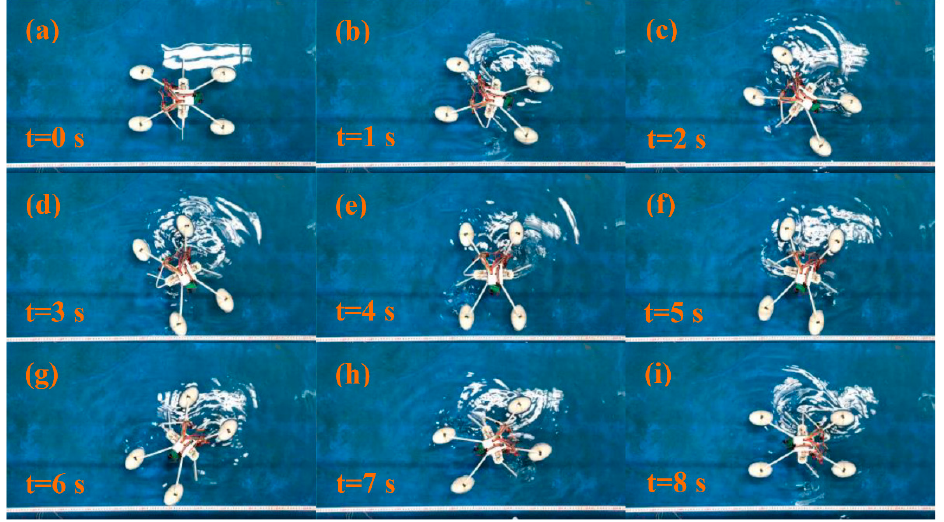
Figure 19. The positions of the robot at different times t: ( a ) 0 s, ( b ) 1 s, ( c ) 2 s, ( d ) 3 s, ( e ) 4 s, ( f ) 5 s, ( g ) 6 s, ( h ) 7 s, and ( i ) 8 s, when the robot is turning right.